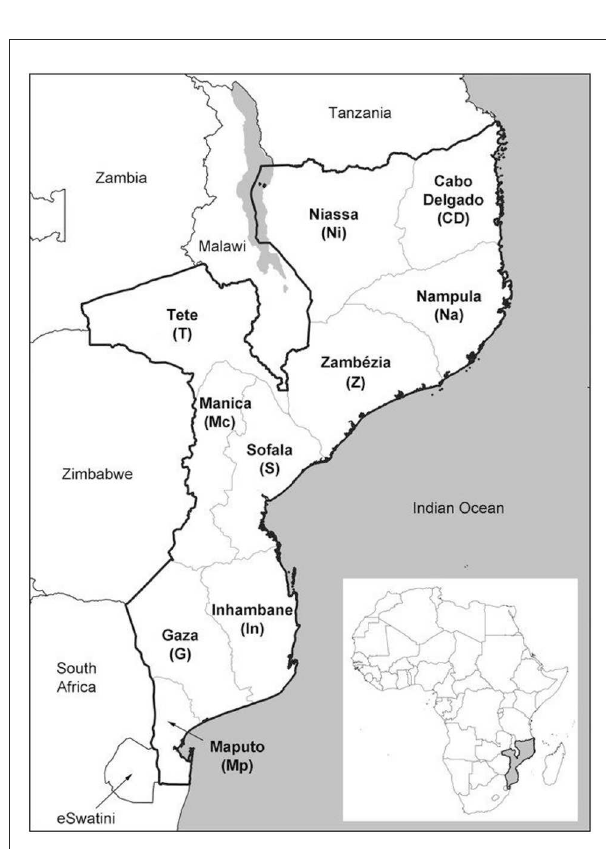
FIGURE1 Map of Mozambique with administrative divisions